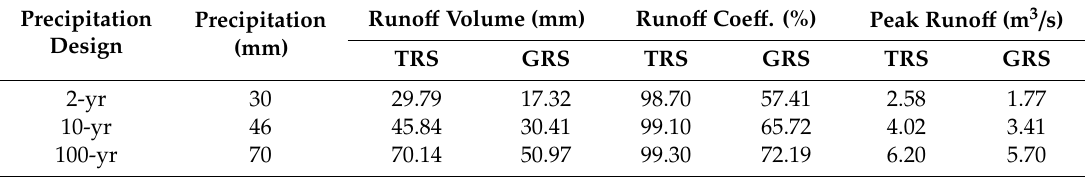
Table 6. Comparison between the TRS and GRS in single event